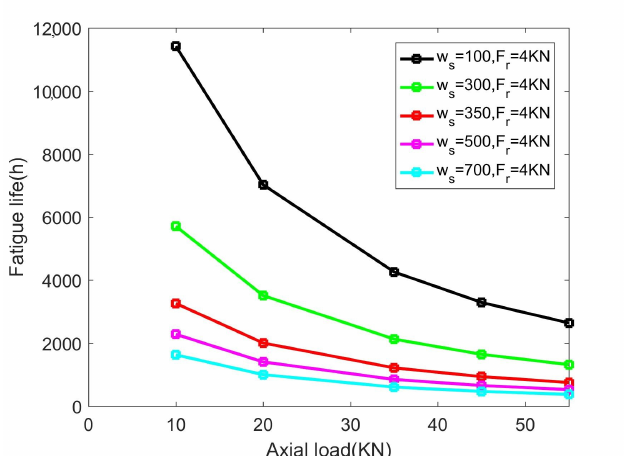
Figure 20. The fatigue life with different axial loads of case 1.